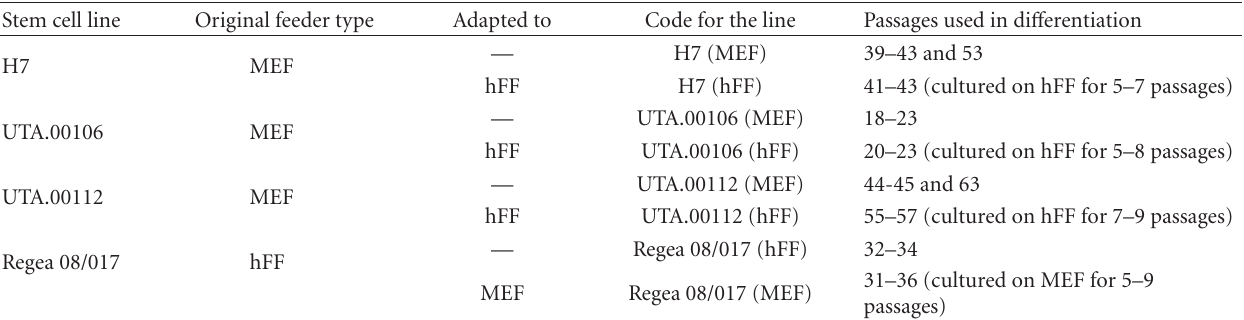
Table 1: Human pluripotent stem cell lines used in present